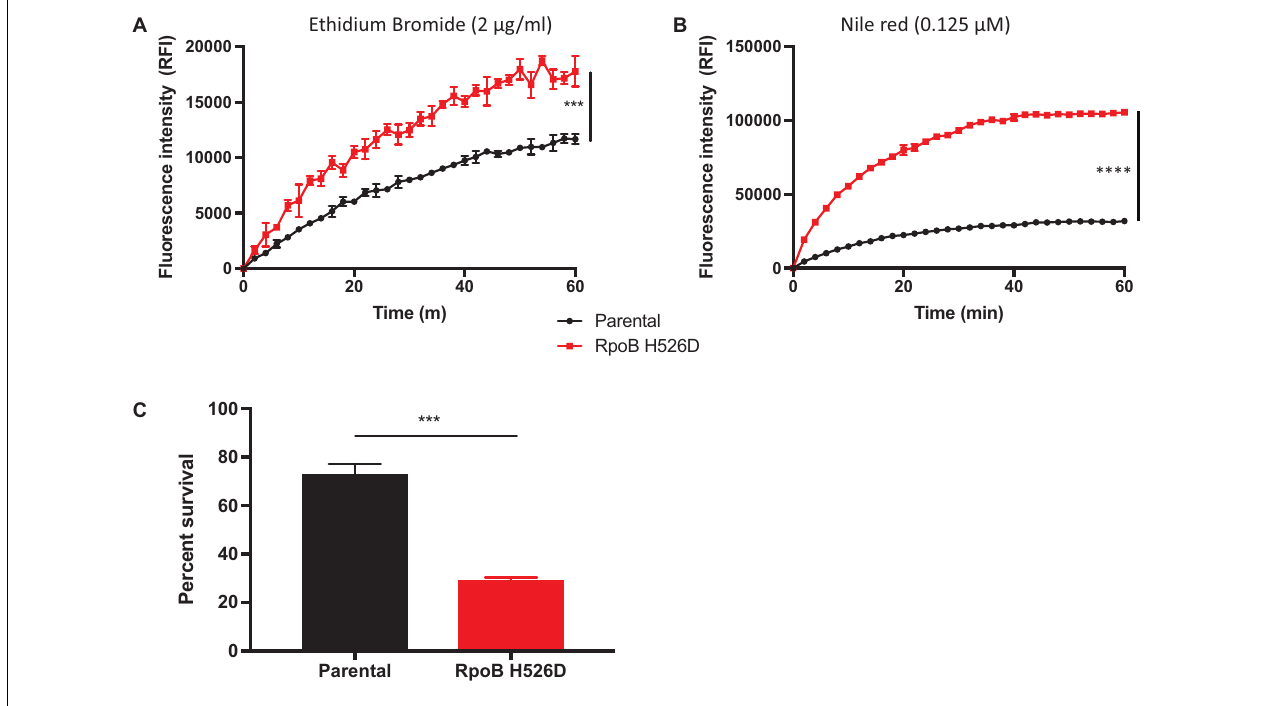
FIGURE 3 | RpoB mutation H526D is associated with altered cell wall permeability and resistance to cell wall stress following nutrient starvation. Intracellular accumulation of ethidium bromide 2 µ g/ml (A) and Nile red 0.125 µ M (B) by the 14-day-nutrient-starved Mtb RpoB H526D mutant and its parental strain were measured by fluorescence spectroscopy. The values at each time point are normalized to the baseline fluorescence value and to bacterial density. RFI, relative fluorescence intensity. (C) Susceptibility of 14-day-nutrient-starved RpoB H526D mutant and parental strain to incubation with 0.05% sodium dodecyl sulfate (SDS) for 6 h. Percent survival represents the number of surviving bacteria after challenge divided by the number of bacteria prior to incubation. ∗∗∗ p < 0.001, ∗∗∗∗ p < 0.0001.